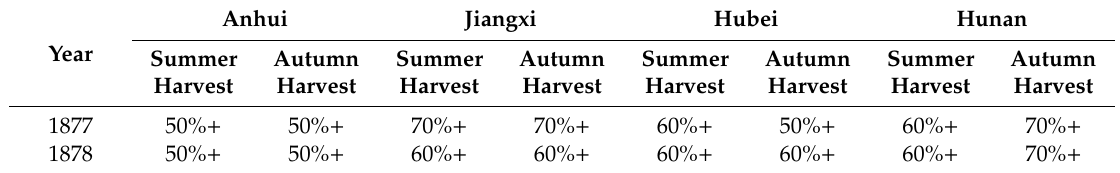
Table 3. Harvest rate of grains in di ff erent provinces